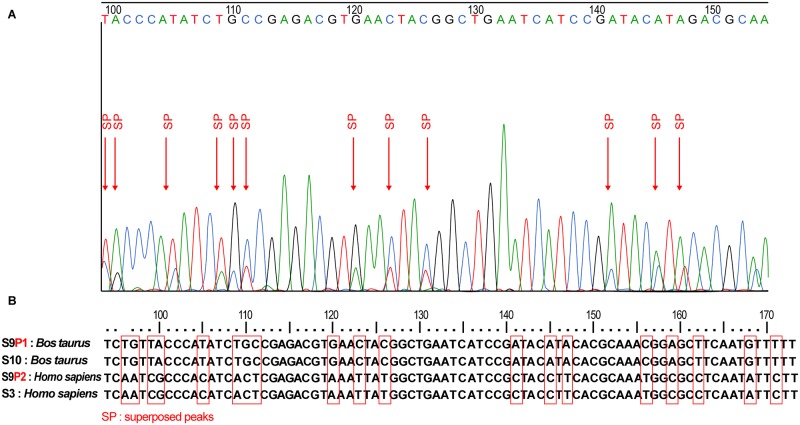
Blood meal identification results.A: electropherogram of part of the sequence S 9 showing superposed peaks, B: part of the alignment of four cytochrome b sequences showing superposed peaks for S9, S 10: cytochrome b sequence of Bos taurus, S 3: cytochrome b sequence of Homo sapiens, S 9: cytochrome b sequence of mixed blood meal (Bos taurus/Homo sapiens), two peaks were detected peak 1 (S9P1 corresponding to Bos taurus sequence) and peak 2 (S9P2 corresponding to Homo sapiens sequence).